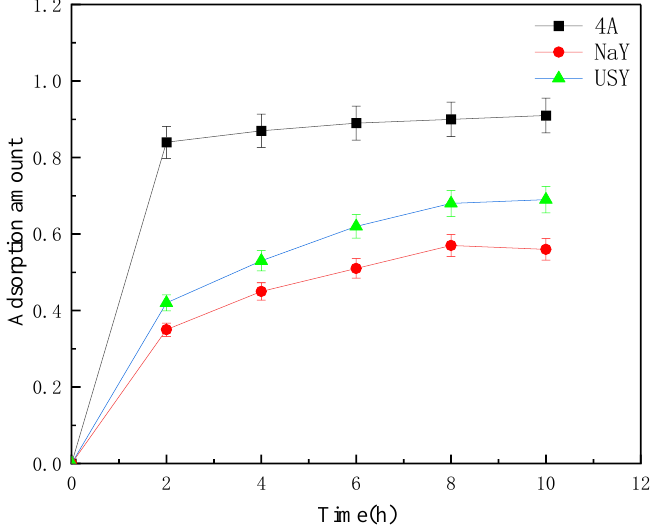
Figure 1. Curve of adsorption amount of three carriers to strain S1 with time.